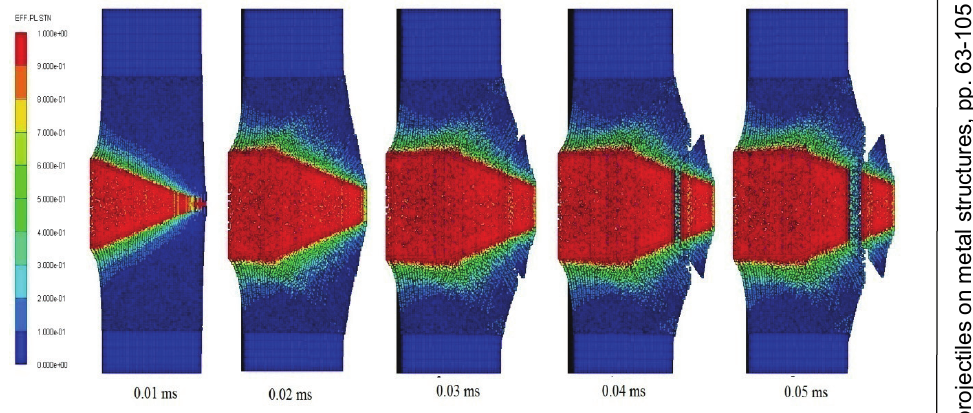
Figure 33 – Perforation of a 15 mm thick steel plate, hemispherical projectile (SFM method)